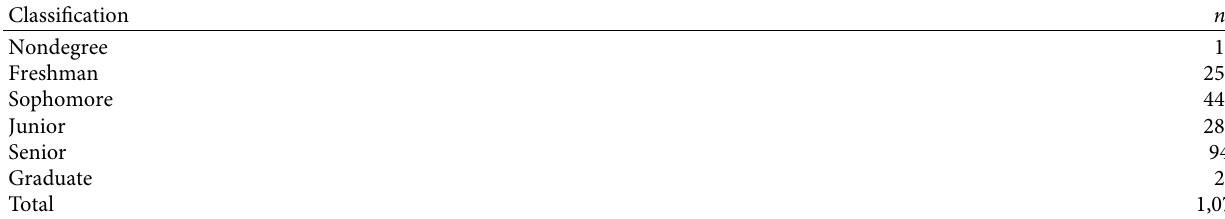
Table 2: Participants distributed by academic level.